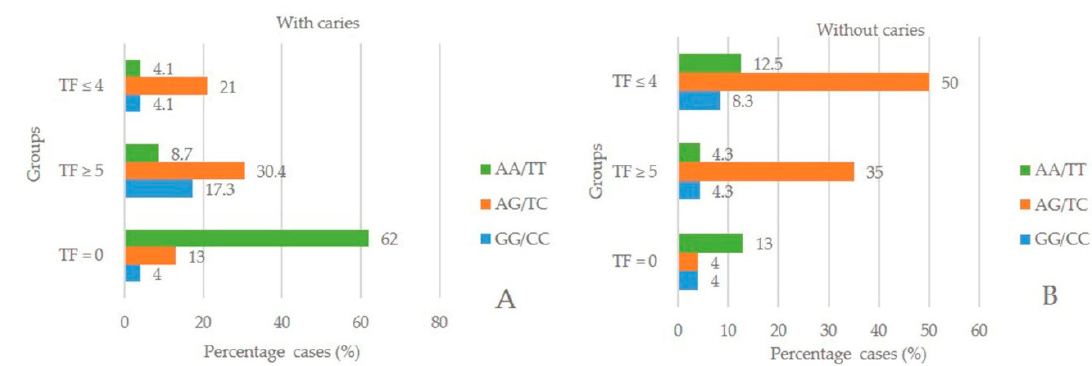
Figure 1. Frequency distribution of alleles in groups with different severity of fluorosis with, and without caries. ( A ) With caries. ( B ) Without caries.